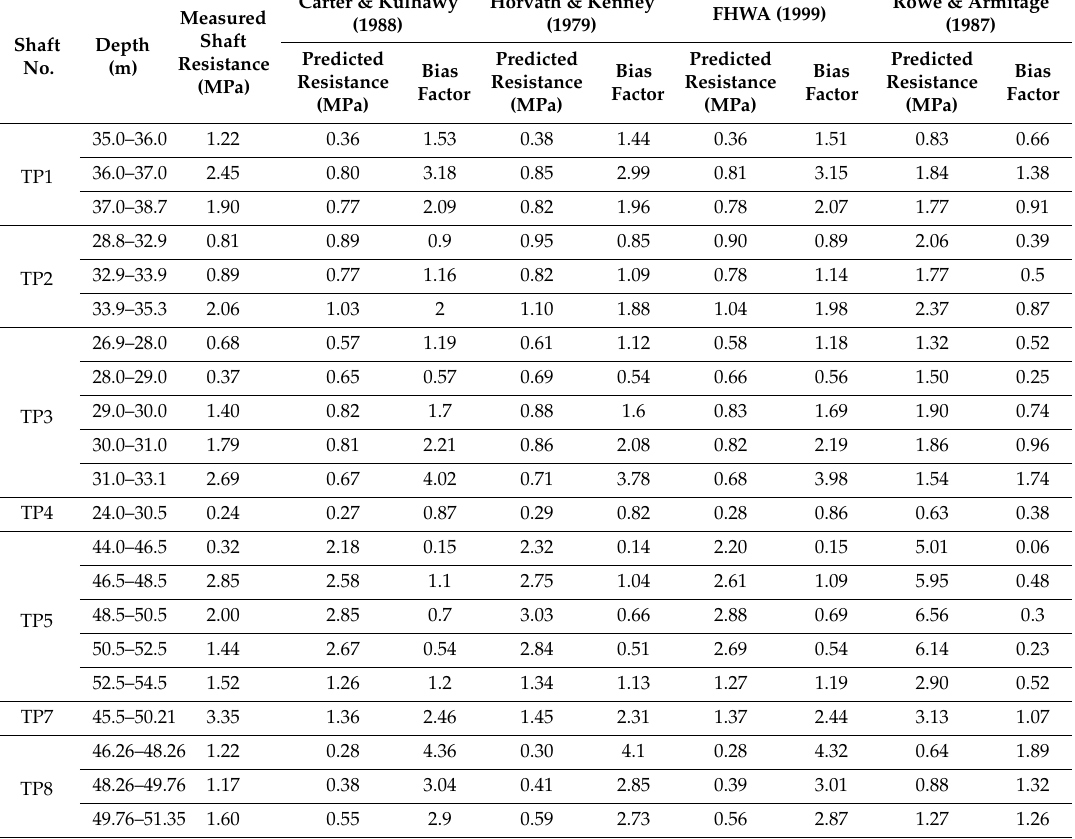
Table 6. Calculated bias factors for shaft